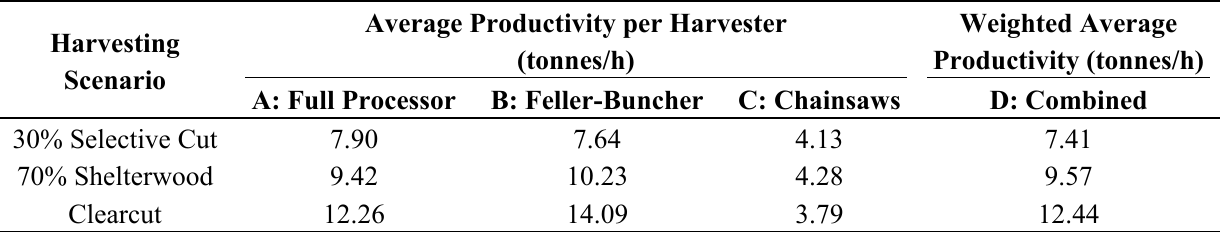
Table 1. Average productivities for different logging equipment configurations.